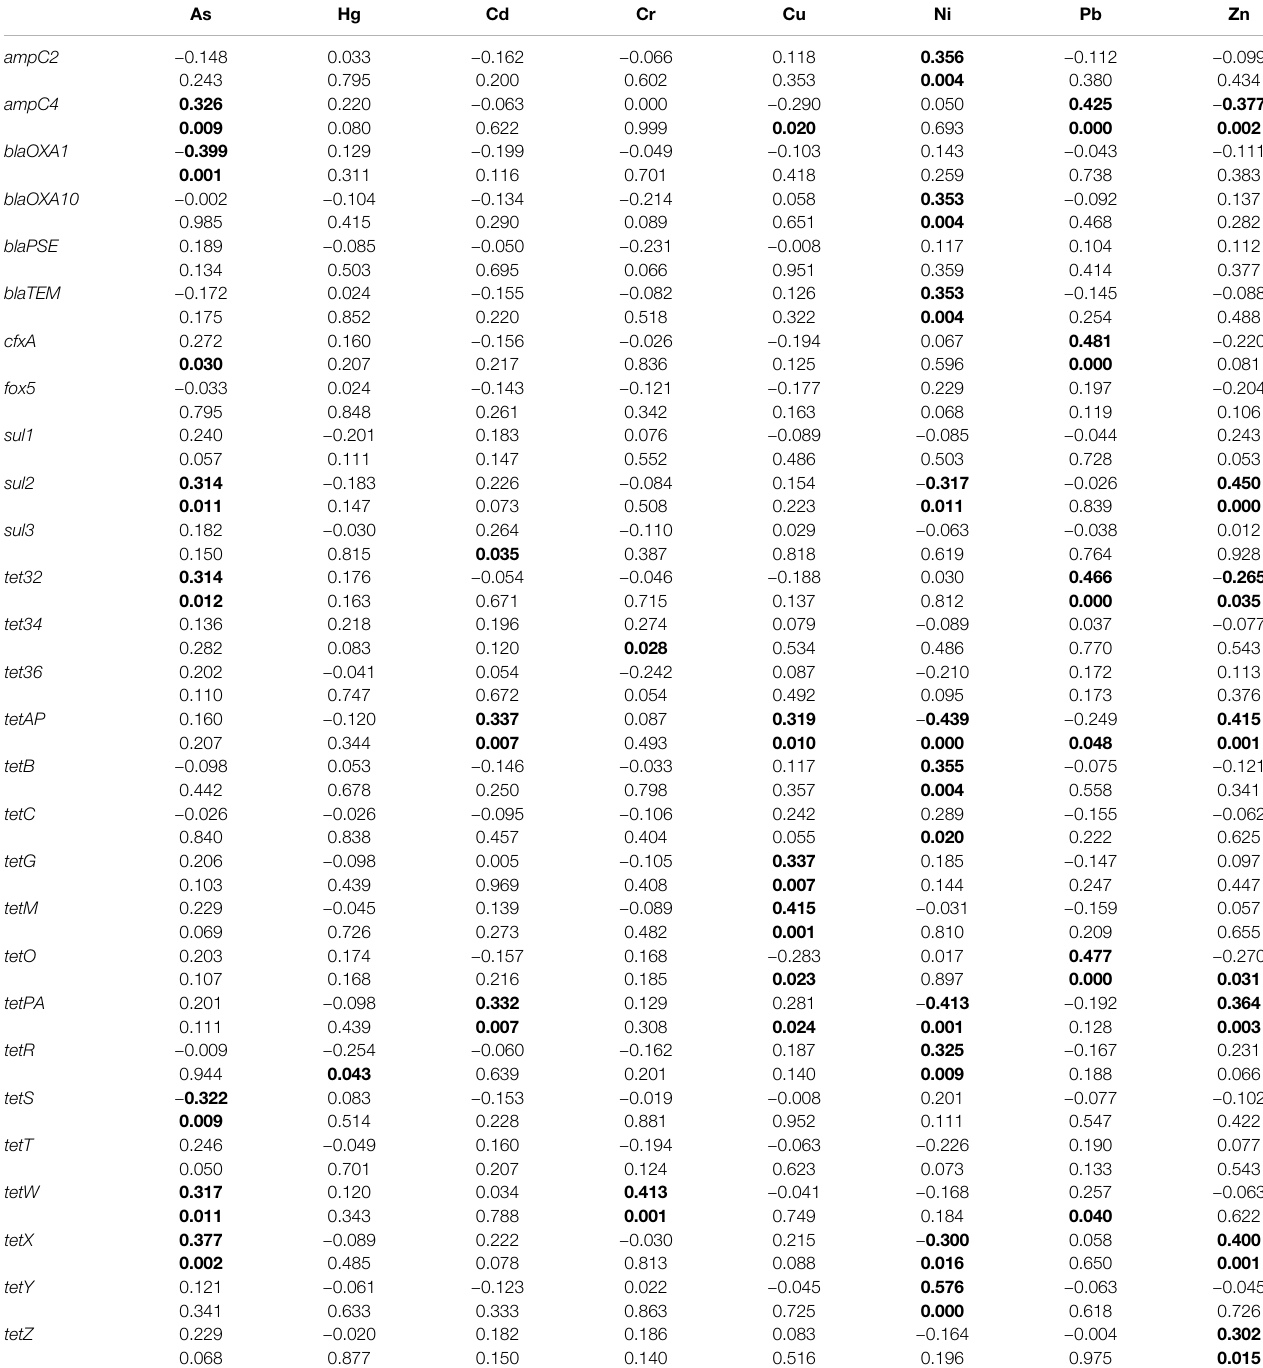
TABLE 5 | The correlations between heavy metal content and relative abundances of the